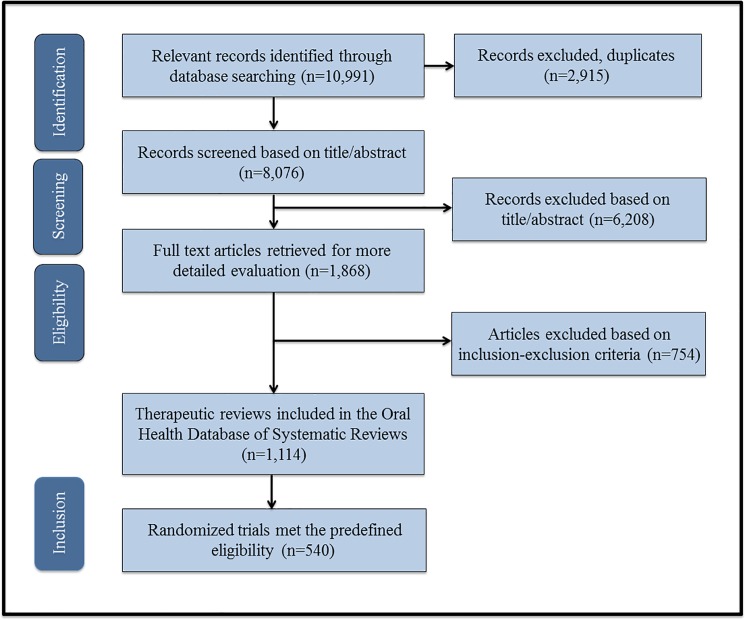
Flow diagram of the literature search [20, 21].